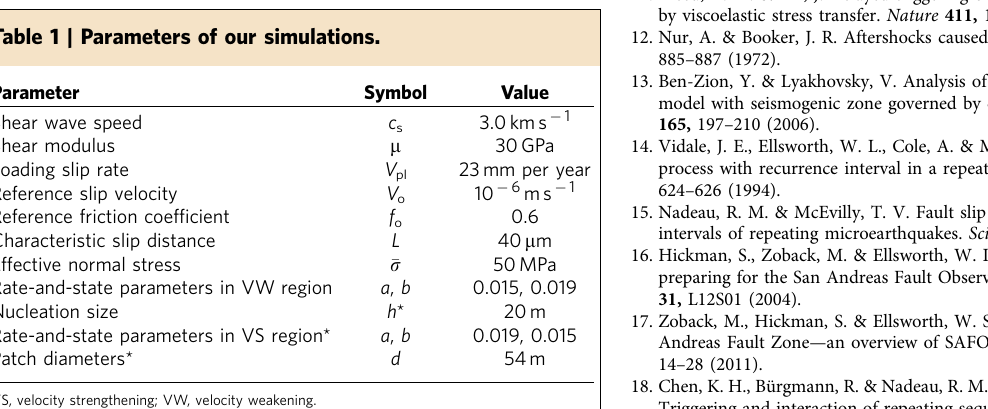
VS, velocity strengthening; VW, velocity weakening. *Unless stated